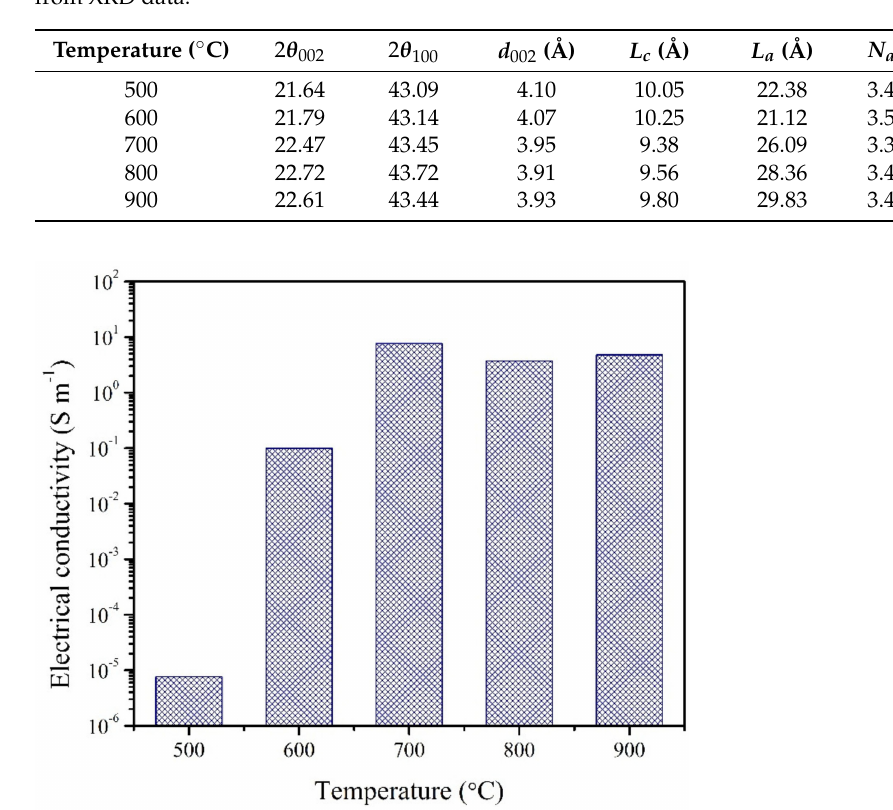
Figure 5. XRD spectra of CXs obtained at different carbonisation temperatures. Table 2. Effect of carbonisation temperature on structural and lattice parameters of CXs, calculated from XRD data.